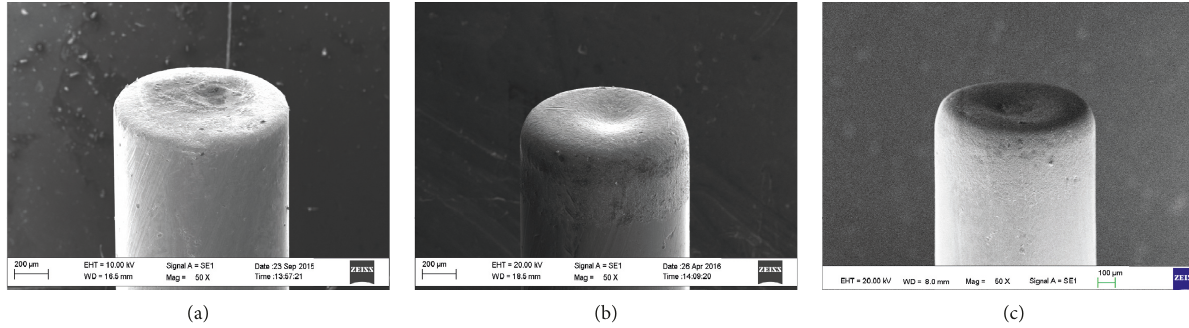
Figure 15: Shape change with electrode jump (no. 1 of Table 1). (a) up000: 0s. (b) up020: 0.2s. (c) up100: 1.0s.